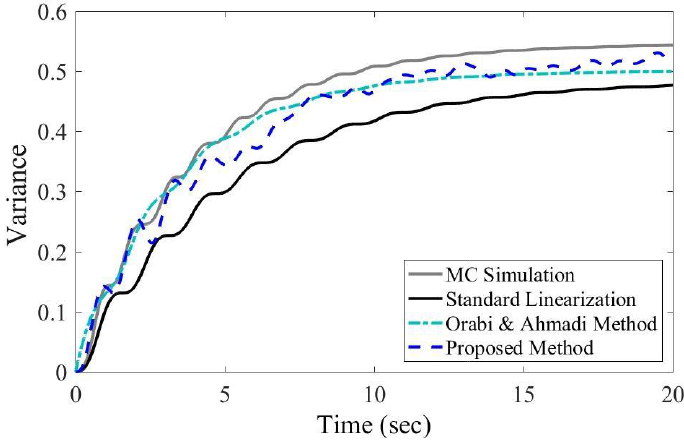
Figure 2. Mean square displacement response due to stationary excitation. ( γ = 1.0, μ = 1.0).